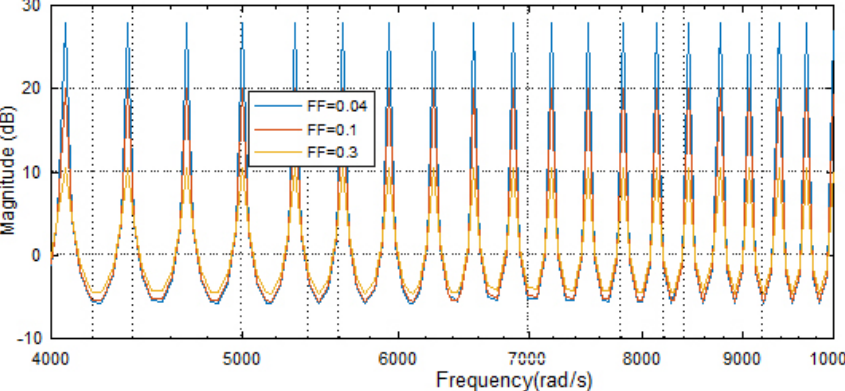
Figure 11. Frequency characteristics of ILC with various forgetting factor (FF).